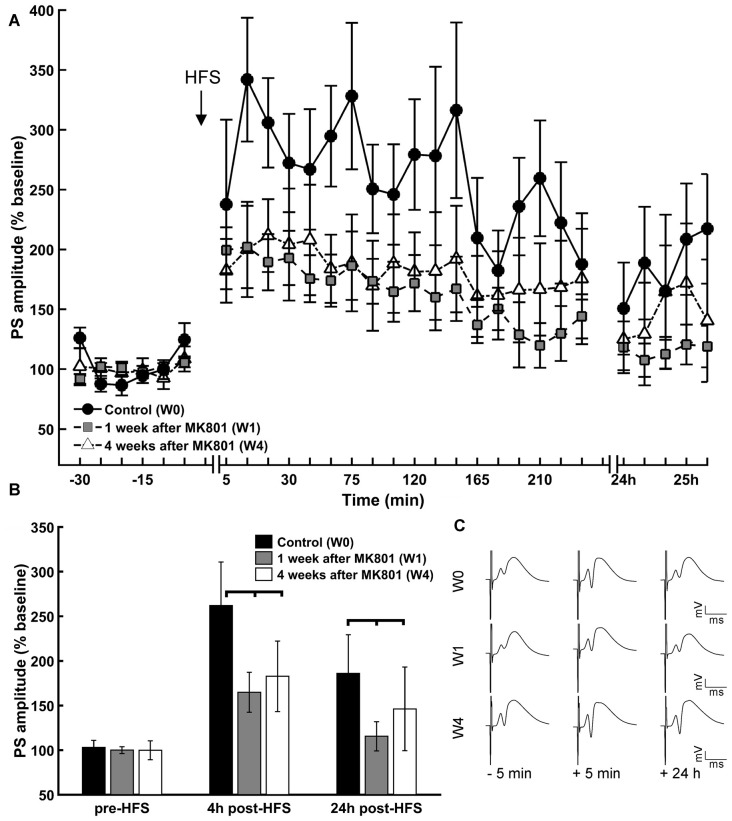
LTP is impaired 1 and 4 weeks after MK801-treatment. (A) HFS of the perforant path resulted in LTP in the DG that persisted for over 24 h in untreated animals (W0). One (W1) and 4 weeks (W4) after MK801-treatment LTP was significantly impaired. (B) Basal synaptic transmission (pre-HFS) was unaffected by MK801 treatment, but 4 h and 24 h after HFS a significant reduction in potentiation was evident in both the W1 and W4 treatment groups. (C) Analog examples of evoked responses obtained 5 min prior to HFS, 5 min and 24 h after HFS in the absence of MK801 treatment (W0), and 1 week (W1) and 4 weeks (W4) after MK801 treatment. Vertical scale bar corresponds to 5 mV; horizontal scale bar corresponds to 5 ms.